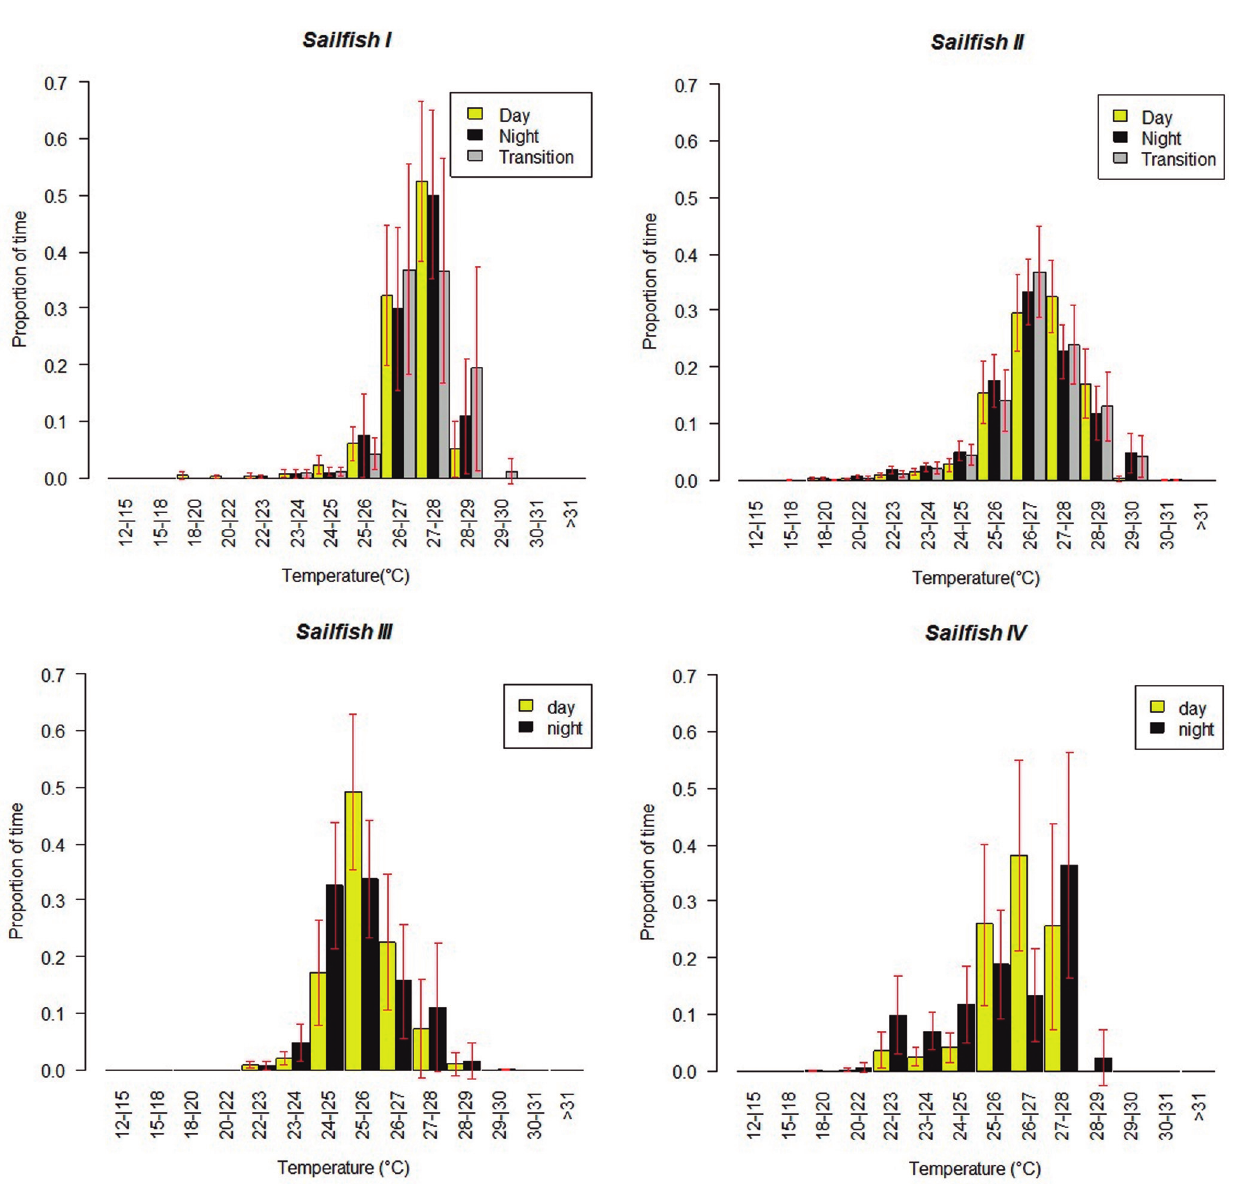
Fig. 2. Temperature histograms, showing the relative frequency of time spent at temperature for each tagged sailfish individual. Error bars indicates the standard errors around mean